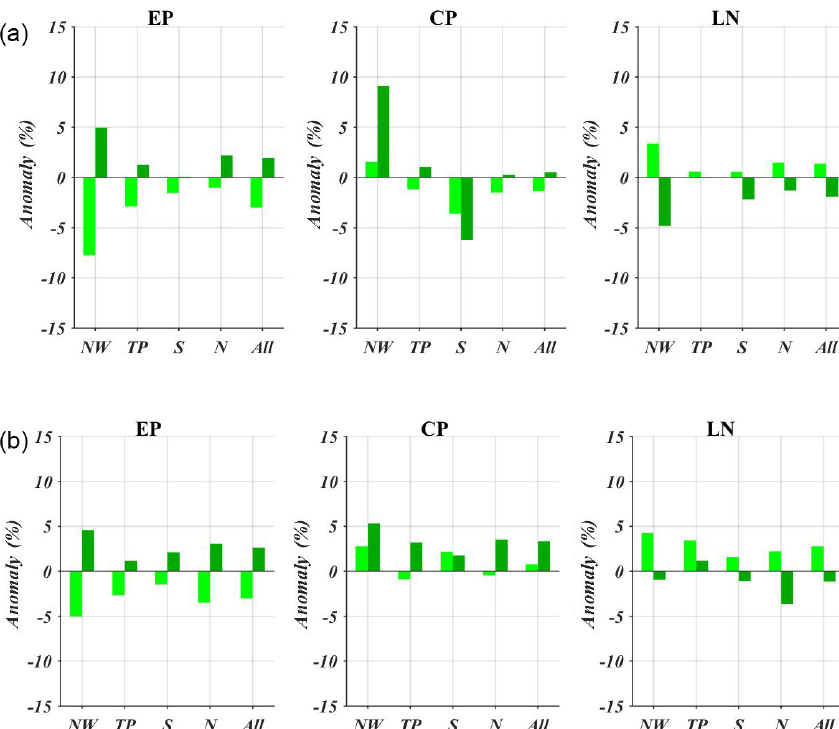
Figure 6. Average anomalies of precipitation frequency (a) and precipitation intensity (b) by subregion during EP, CP, and LN phases. Light green represents developing years, and dark green represents decaying years.